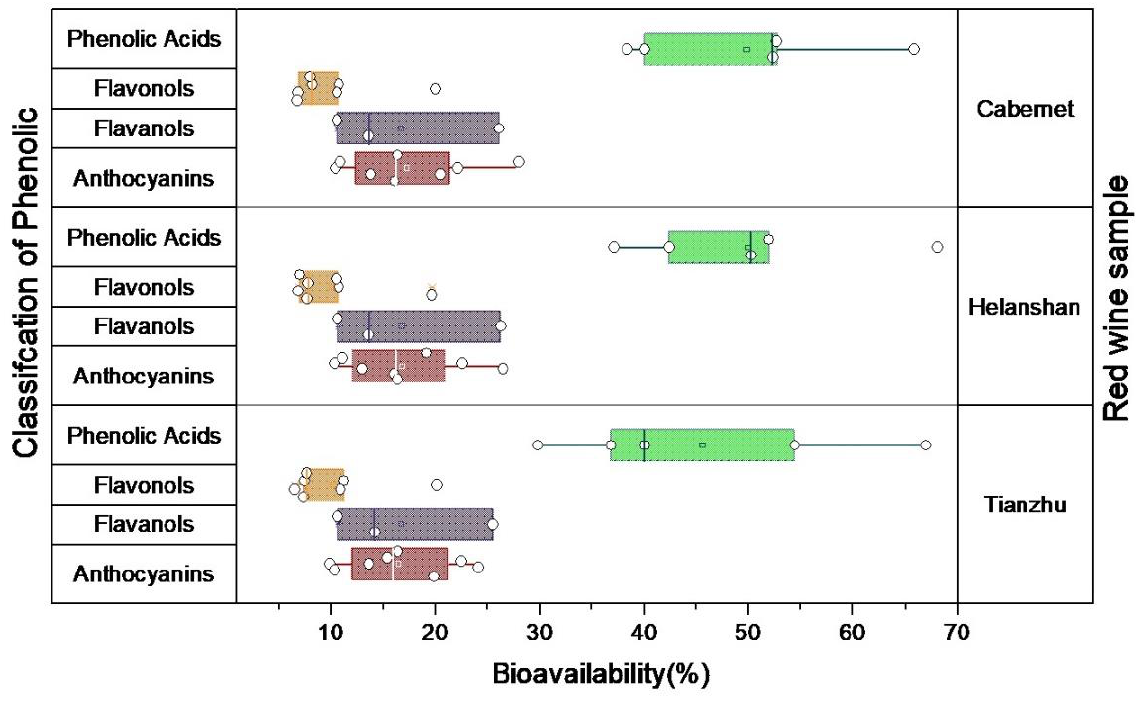
Figure 1. Bioavailability of four kinds of PCs. Table 3. Antioxidant activity of red wine at different digestion